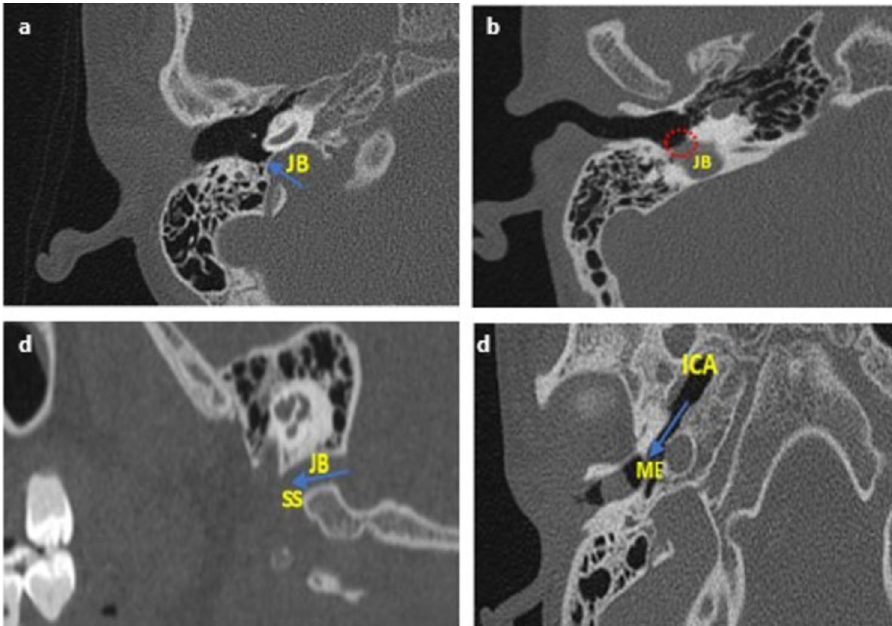
Figure 2. Diagrammatic representation of all vascular variants on the axial and sagittal plane. JB jugular bulb, ICA internal carotid artery, ME middle-ear, SS sigmoid sinus. ( a ) HJB- blue arrow showing the bulb rising to the sigmoid plate; ( b ) JBD- red dotted circle showing absence of sigmoid plate due to descent of JB into the middle ear; ( c ) FJB- absence of the dome (rising bulb), blue arrow showing SS continue into the internal jugular vein; and ( d ) ICA-Deh: blue arrow showing focal dehiscence of the carotid canal into the middle ear.